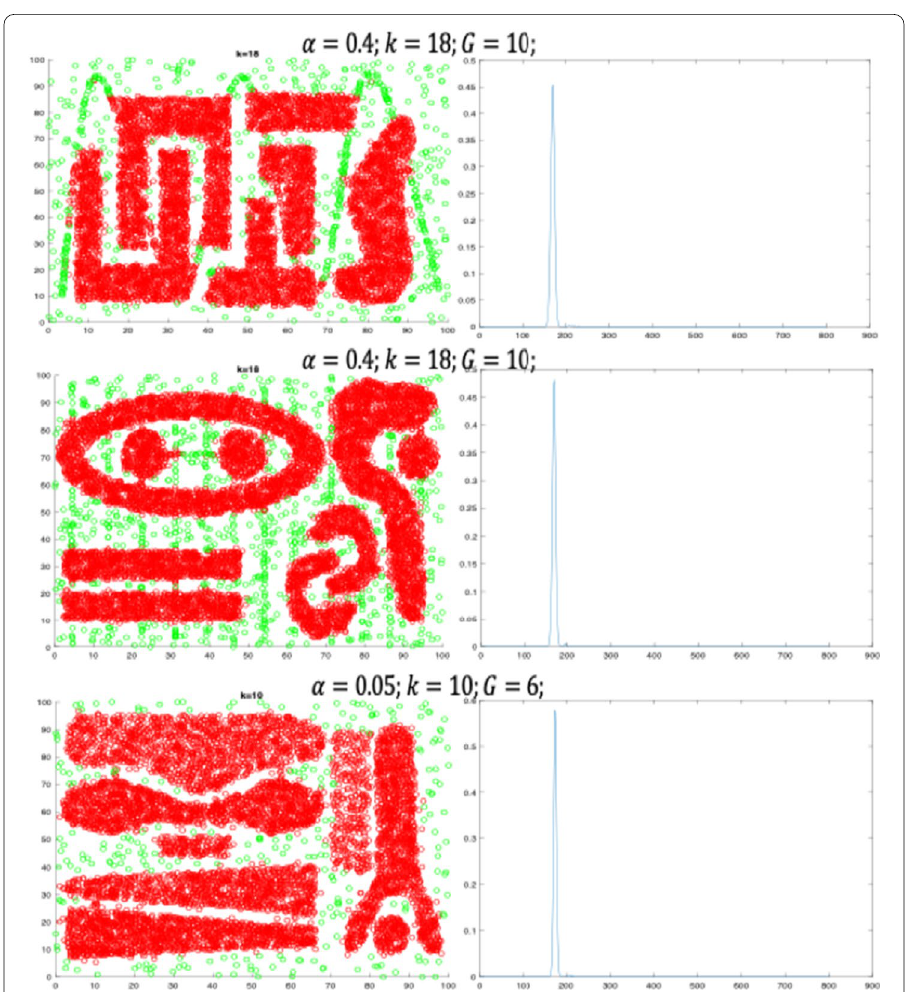
Fig. 11 Results achieved on three different datasets with different distribution of noise using the proposed GMM estimation of d k . The data points in red are the inliers and the green data points are identified as the